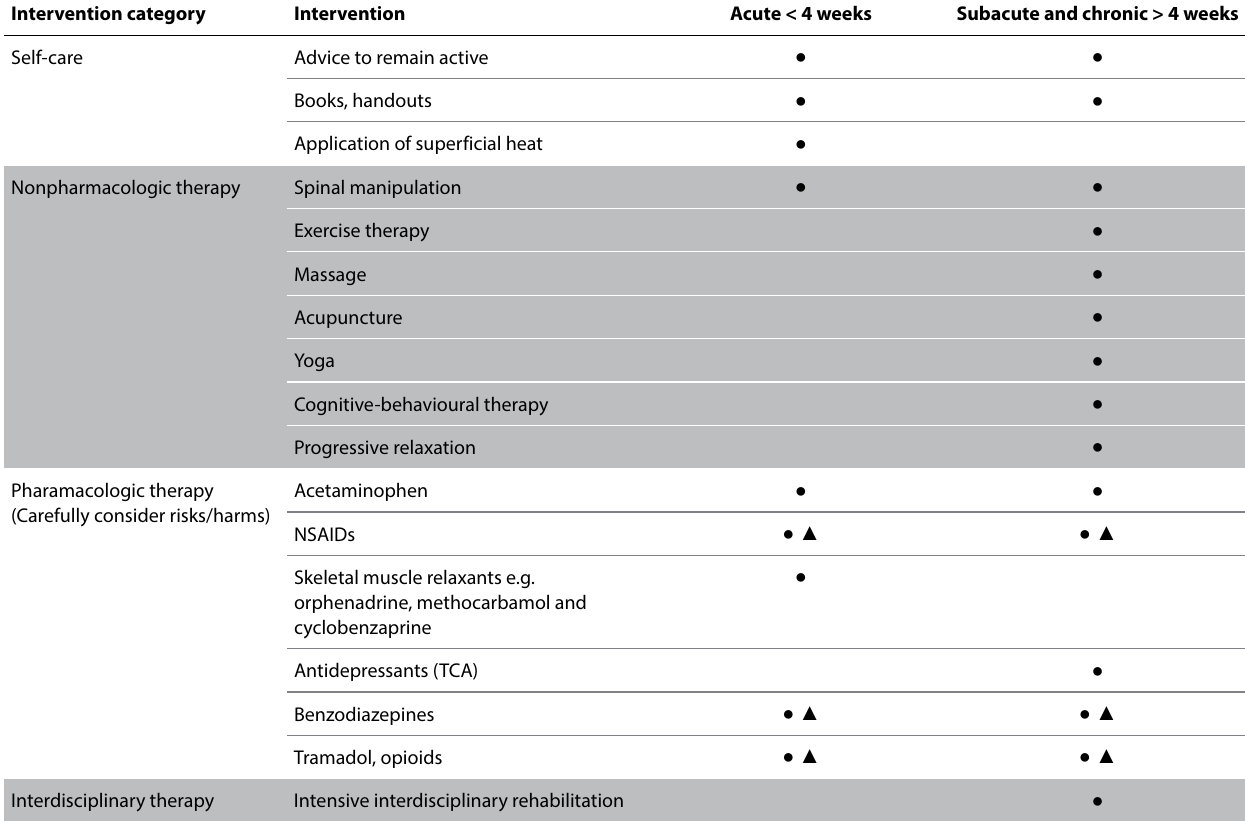
Table I: Interventions Intervention category Intervention